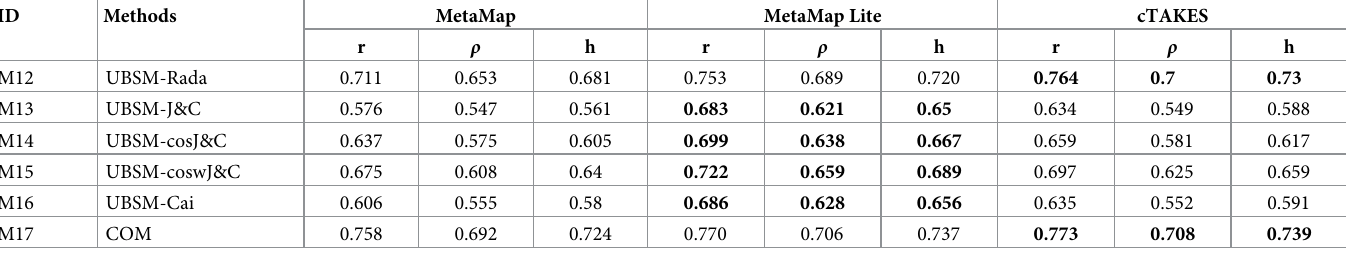
Table 10. Pearson (r), Spearman ( ρ ) and harmonic ( h ) values obtained in our experiments from the evaluation of ontology similarity methods detailed below in the MedSTS full [52] dataset for each NER tool.